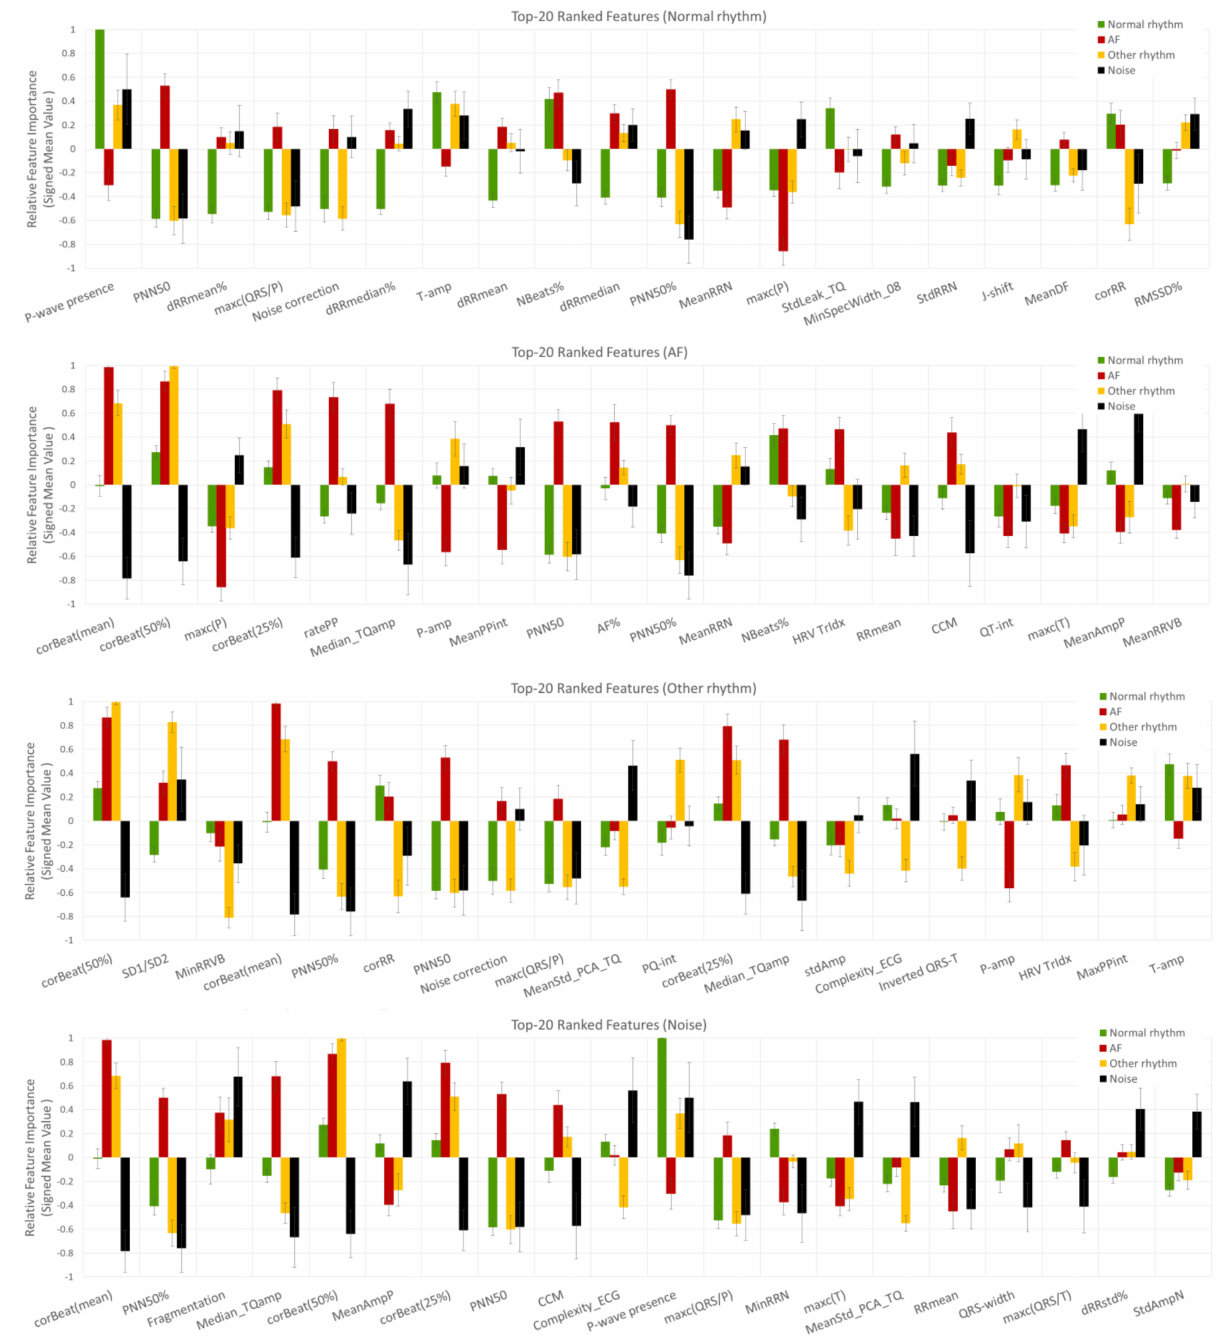
Figure 10. Visual representation of signed Relative Feature Importance for the top-20 features ranked in Table 6 to maximally contribute to the detection of each of the four rhythm classes. The bars and whiskers represent the mean values and standard deviations of the Relative Feature Importance computed by 20 × 5-fold independent runs of DenseNet-3@128-32-4 model. Signed values of Relative Feature Importance are normalized in the range [ − 1; 1]. They comprehensively indicate the value of the feature that would contribute the positive detection of specific class, i.e., positive sign specifies high feature value and negative sign specifies low feature